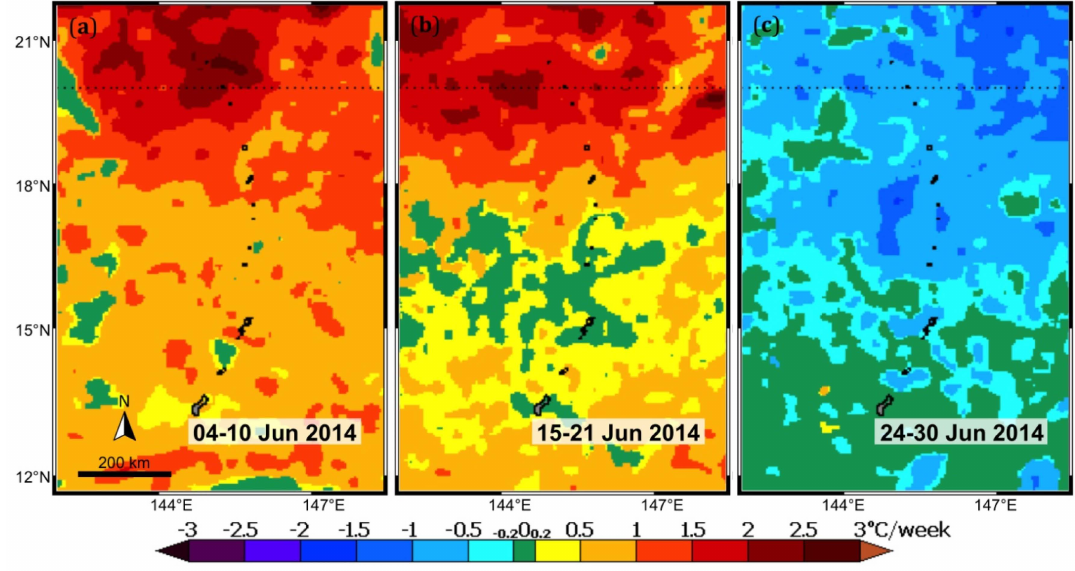
Figure 5. Maps of 5 km Seven-day SST Trend for the Mariana Archipelago during June 2014. Regional SST peaked on ( a ) 10 June 2014 and ( b ) 21 June 2014, with a rapid cooling event culminating on ( c ) 30 June 2014 (see also Figure